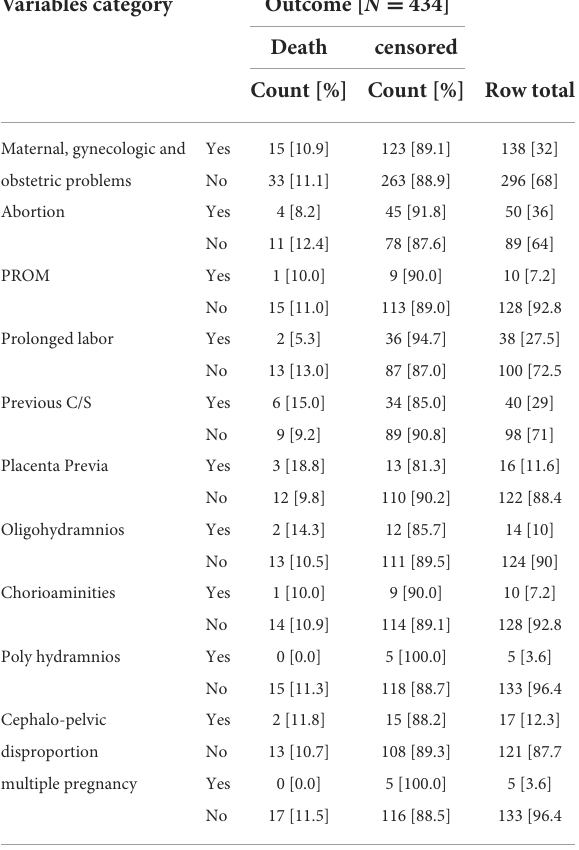
TABLE 4 Maternal medical and related conditions NICU, TASH, Addis Ababa, Ethiopia, from 1 January 2015 – 30 December